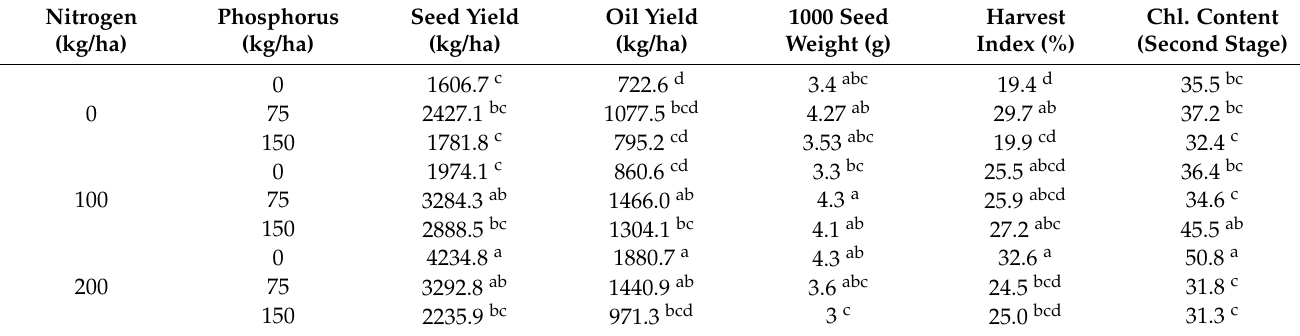
Table 4. Effects of N and P application on seed yield and yield components of rapeseed.